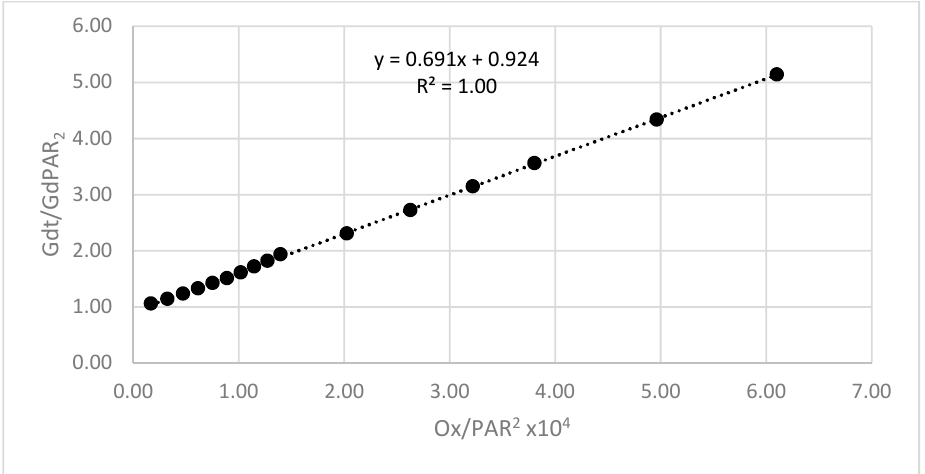
Figure 3. Graphical estimate of the Gd 3+ –oxalate stability constant. The linearity of this plot indicates that GdOx + and Gd(PAR) 2 are the predominant species under these experimental conditions.